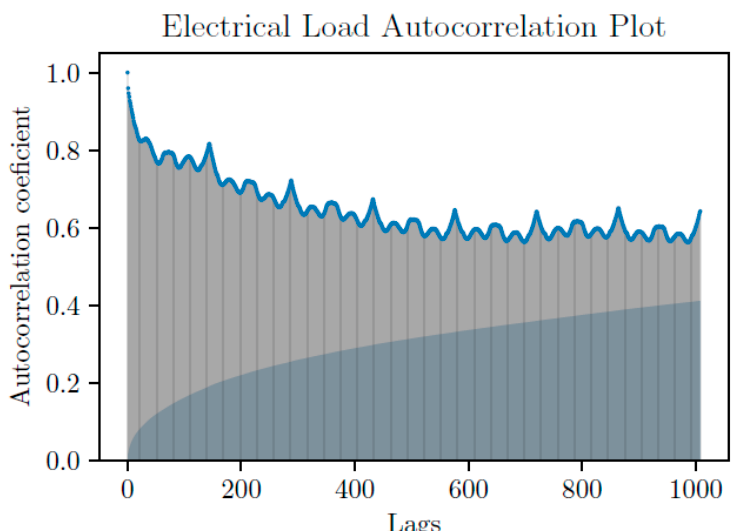
Figure 7. Electrical load database autocorrelation.